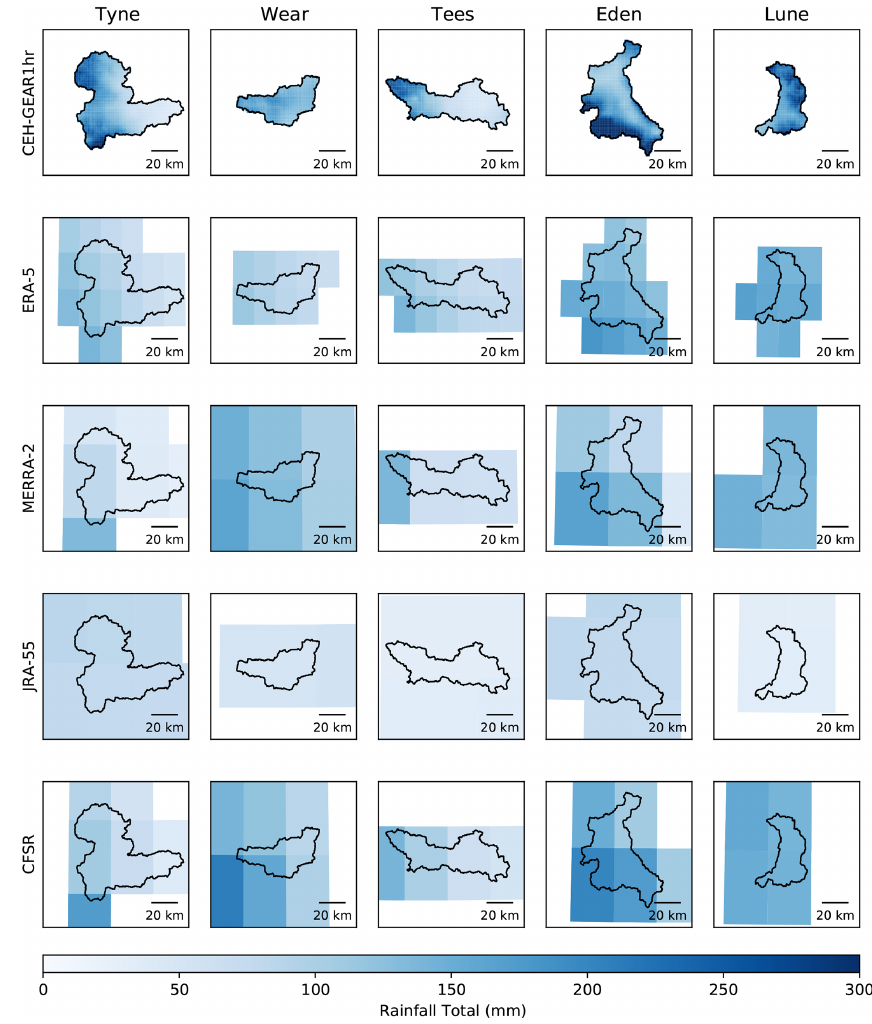
Figure 3. Rainfall over the study area during the events in Table 2, according to each reanalysis dataset. The 1995 event is shown for the Tees and the Lune, the 2004 event is shown for the Tyne and the Eden, and the 2009 event is shown for the